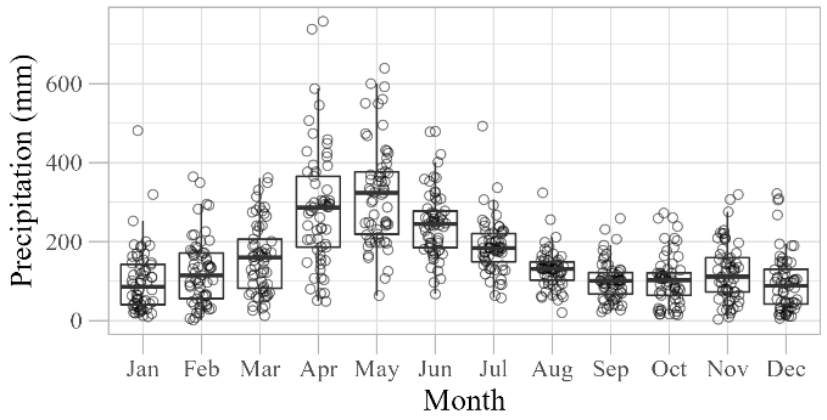
Figure 8. Monthly rainfall boxplot (mm) in SNEB — Salvador from 1960 to